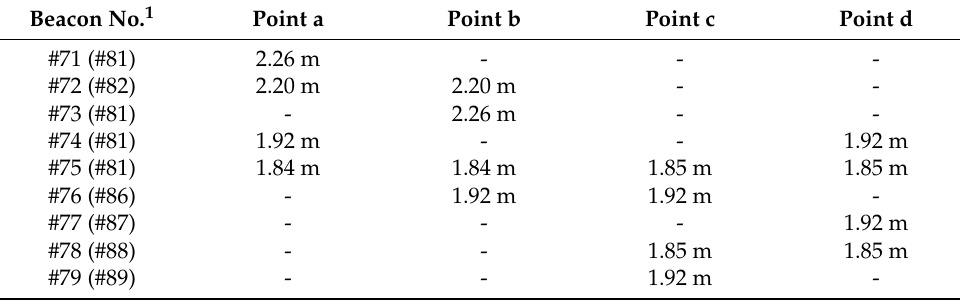
Table 6. The distance between the beacons and measurement point